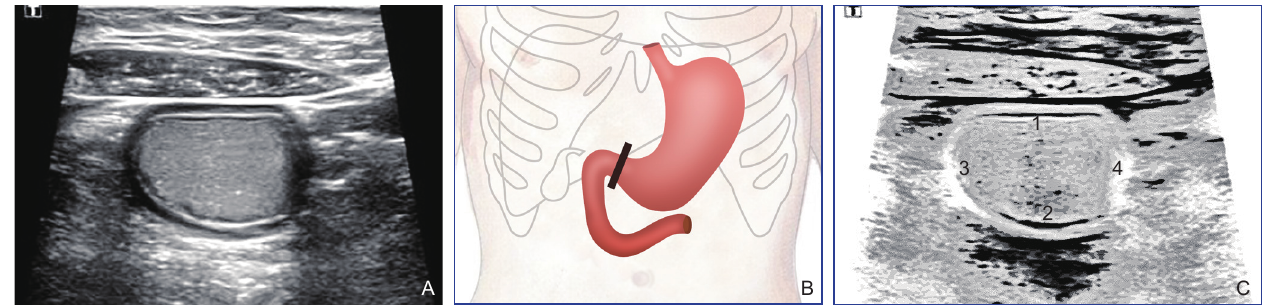
Figure 14 Ultrasonogram and schematic diagram of short-axis section of gastric antrum (scan through right upper abdomen). A, Ultrasonogram; B, Schematic diagram; C, Schematic diagram of ultrasound (1, Anterior wall of gastric antrum; 2, Posterior wall of gastric antrum; 3, Lesser curvature of gastric antrum; 4, Greater curvature of gastric antrum)